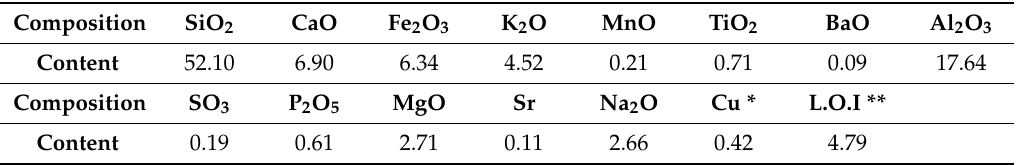
Table 1. Chemical analysis of the representative sample obtained from Abbas Abad copper mine (wt.%).